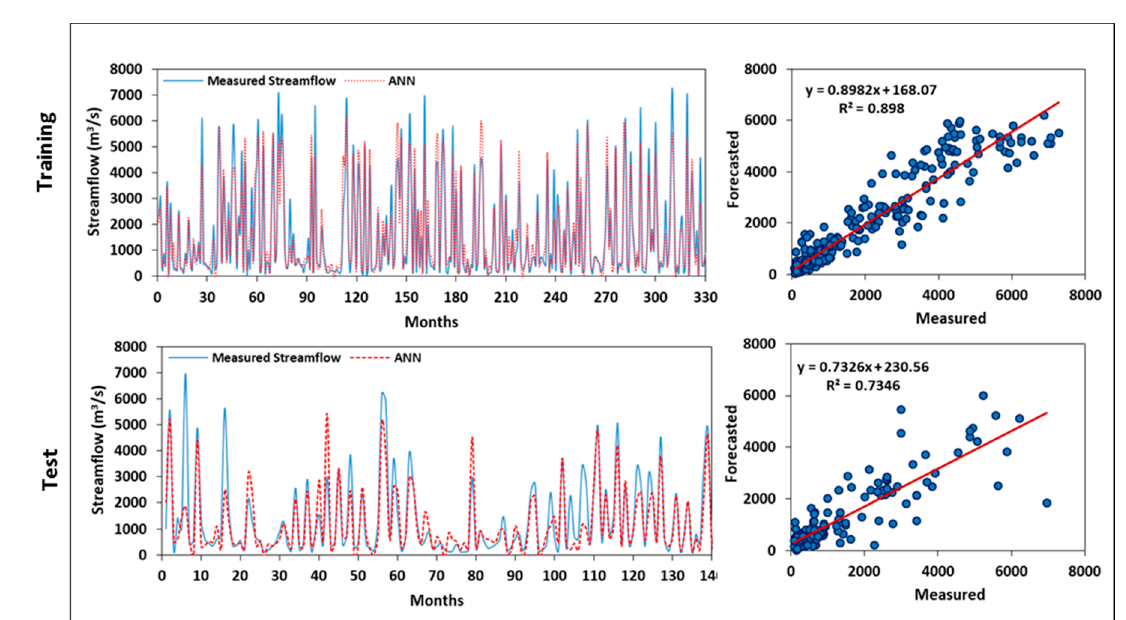
Figure 8. SVM training and test results of the simulated monthly streamflow at El Diem station based on the CHIRPS dataset.